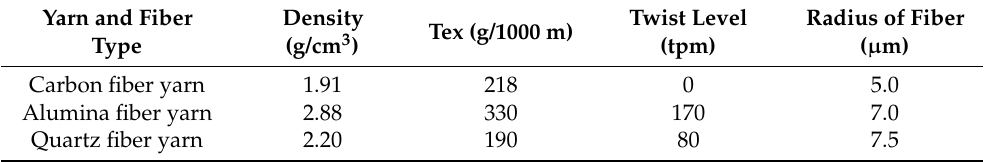
Table 1. Material properties of investigated samples given by the manufacturers.